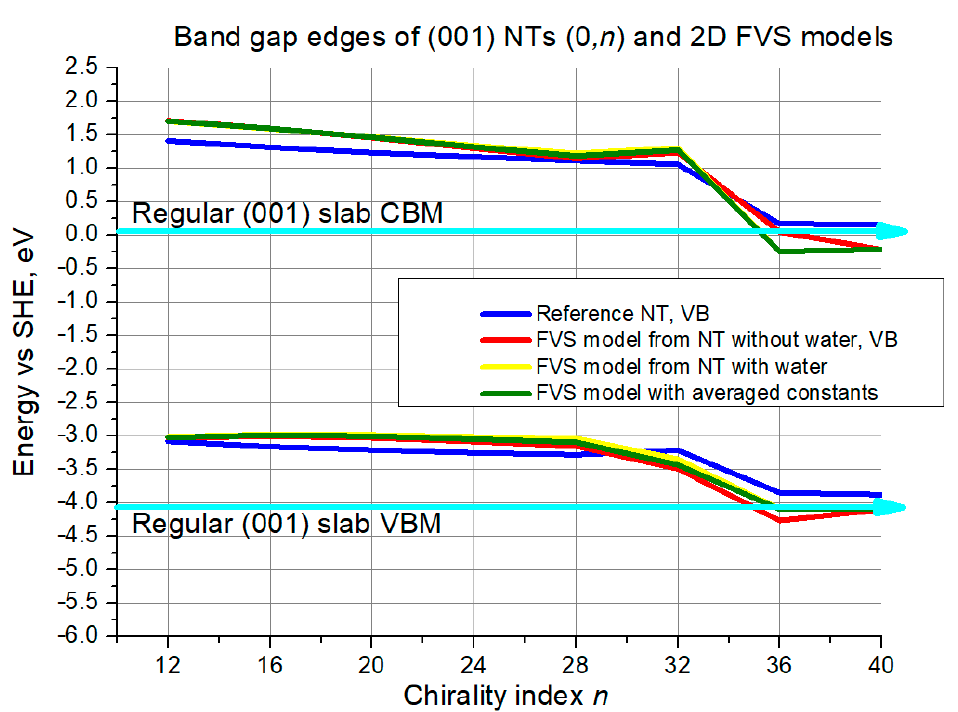
Figure 15. VB top and CB bottom edge positions for (001) NTs (0, n ) and their 2D FVS models. The cyan lines with arrows denote slab limits for VB maximum and CB minimum.